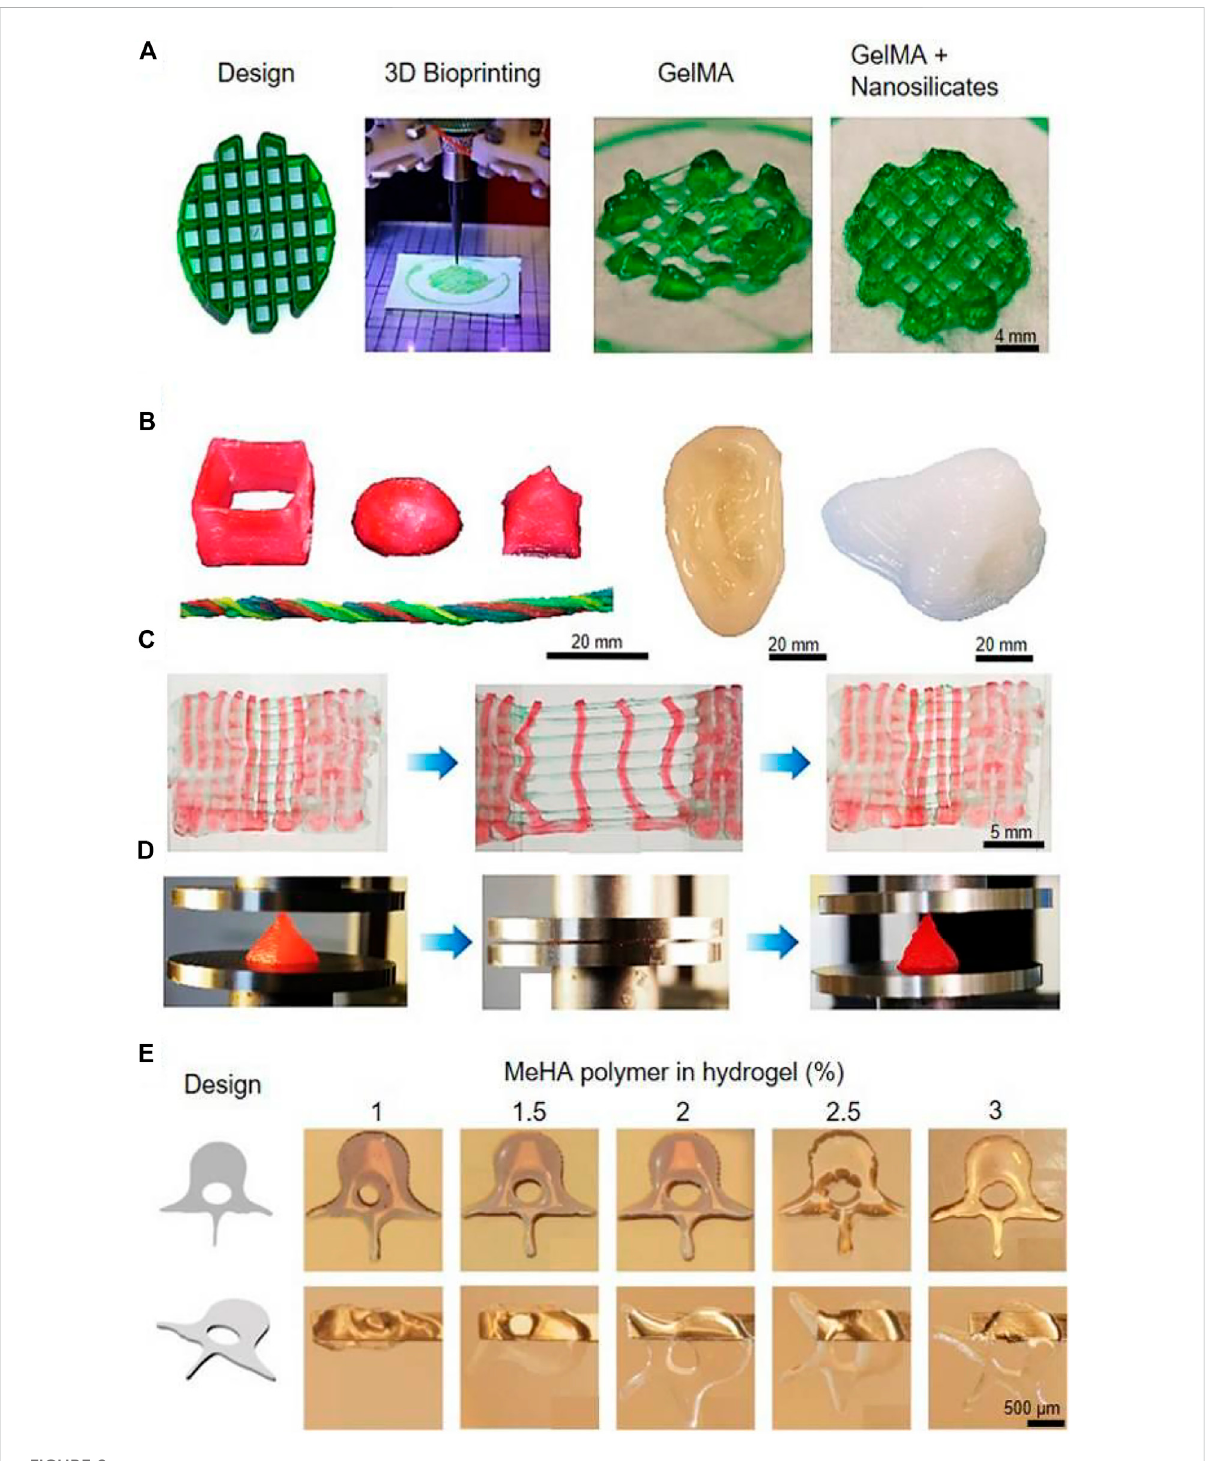
FIGURE 2 (A) Bioprinting of GelMA for rigid complex structures. (B) Various 3D constructs were bioprinted with a PEG hydrogel. (C) Bioprinted PEG undergoing repeated stretching and recovering tests. (D) Bioprinted PEG undergoing repeated compressions and recovering tests. (E) Human spine vertebrae bioprinted with concentrations of MeHA in the bioink. Reproduced with permission from ref (Heinrich et al.,